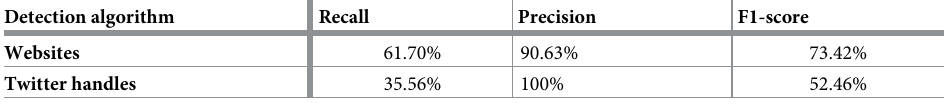
Table 1. Recall , Precision and F1-score of the Website and Twitter Handle Detection Algorithm based on a sample of 200 companies from the 112,653 companies in the IT sector. Detection